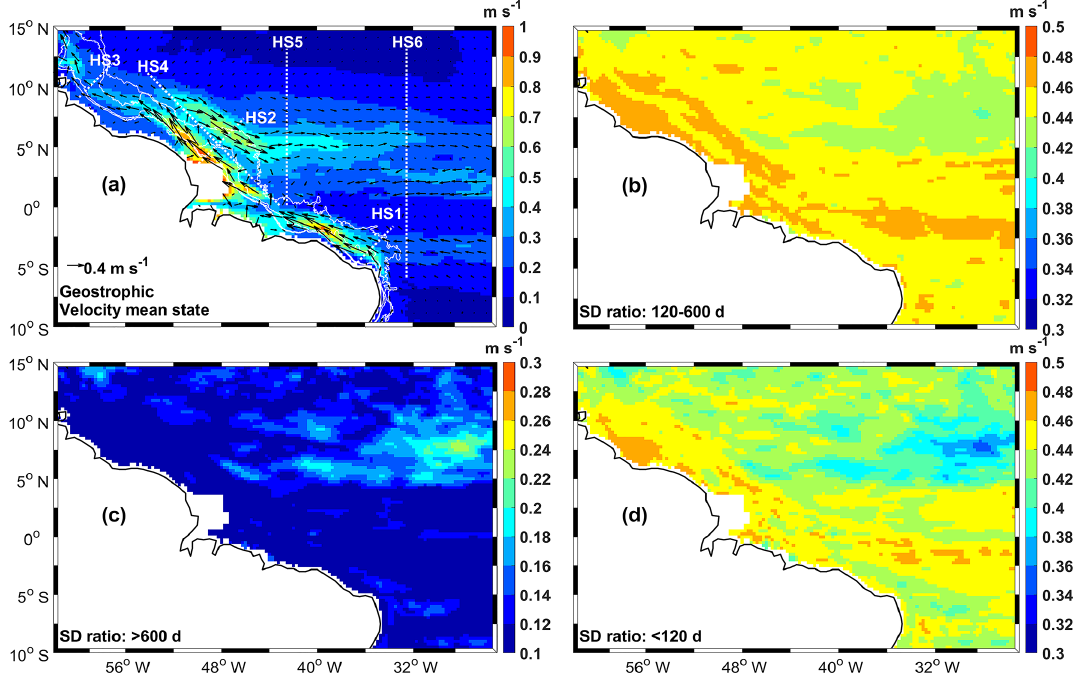
Figure 2. (a) Temporal mean of the geostrophic currents (amplitude in ms − 1 and vectors) in the study area between 1993 to 2017. Panels (b) , (c) , and (d) show the ratios between the standard deviations of the currents for the signals between 120 and 600d, longer than 600d and shorter than 120d, respectively, and the standard deviation of the total currents. The dashed white lines labeled HS1, HS2, HS3, HS4, HS5, and HS6 in (a) represent the cross sections of the currents, and the solid white lines are the 300, 1000, 3000, and 4000m isobaths. Note that the color bar in (c) is different from the ones in (b) and (d)